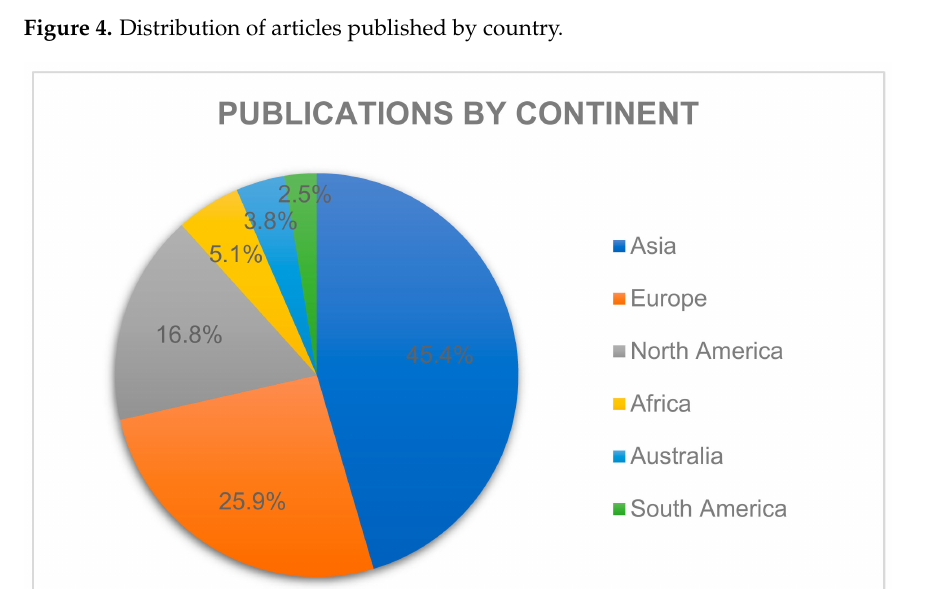
Figure 5. Distribution of articles published by